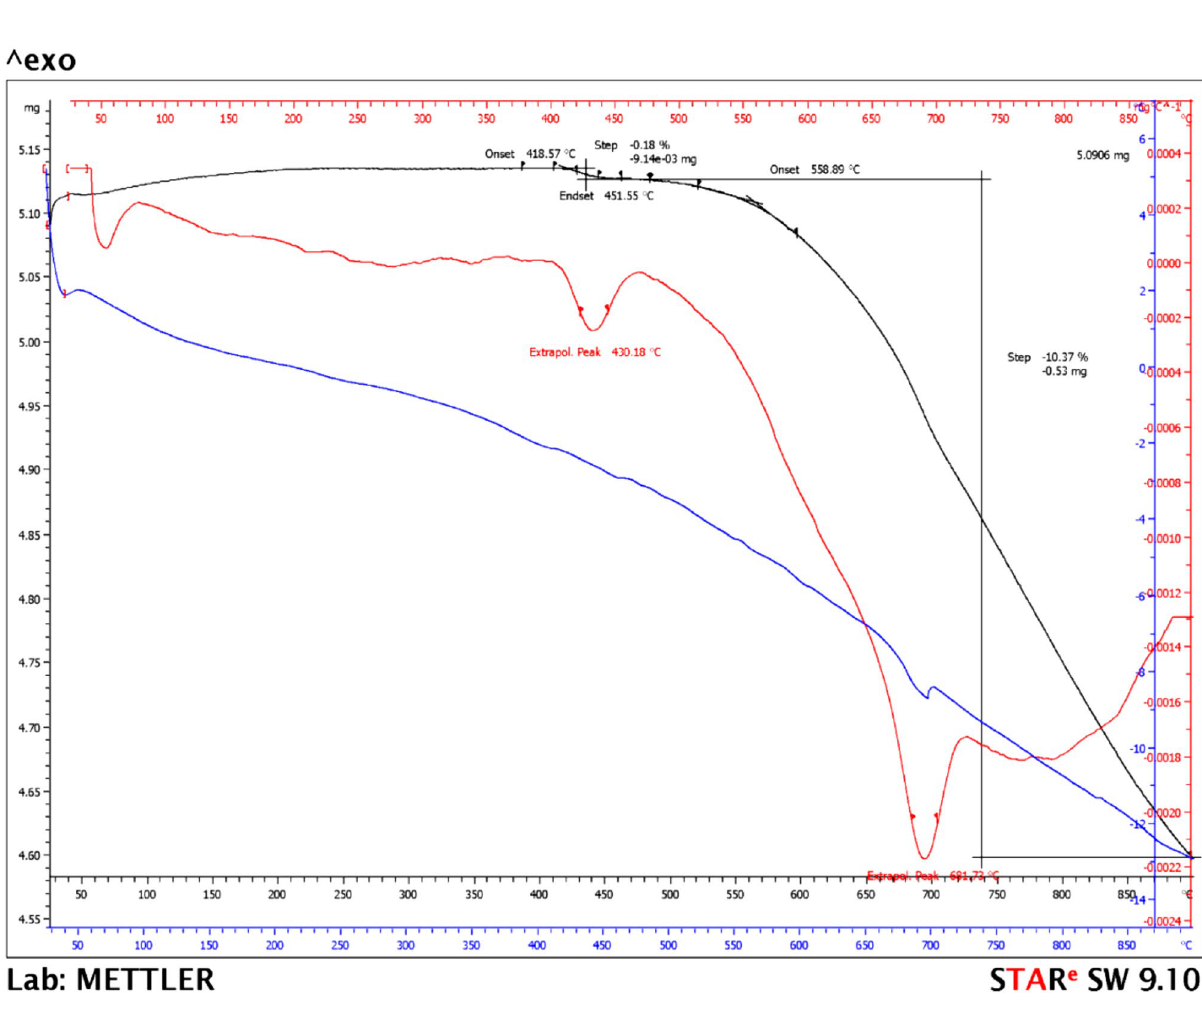
Figure 7. TGA of fly ash in N 2 atmosphere (10